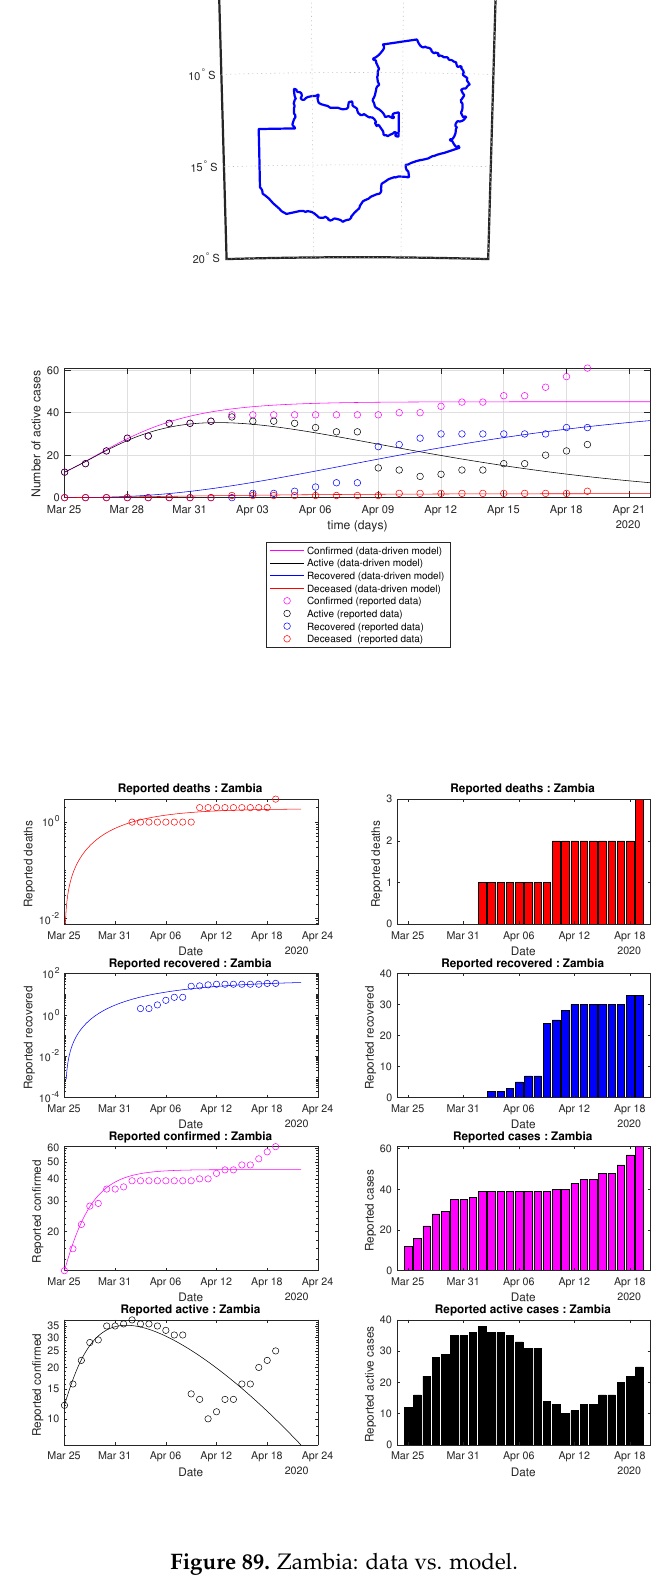
Figure 89. Zambia: data vs.